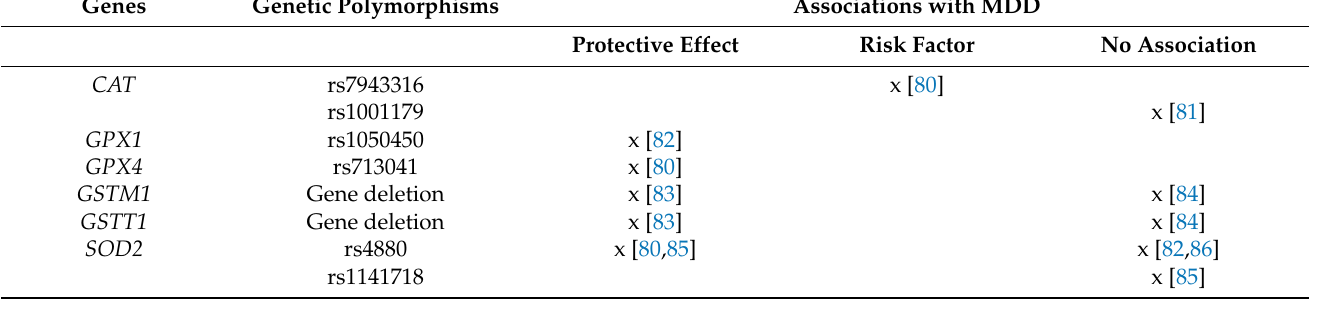
Table 9. Associations between genetic polymorphisms of antioxidant enzymes and the preva-